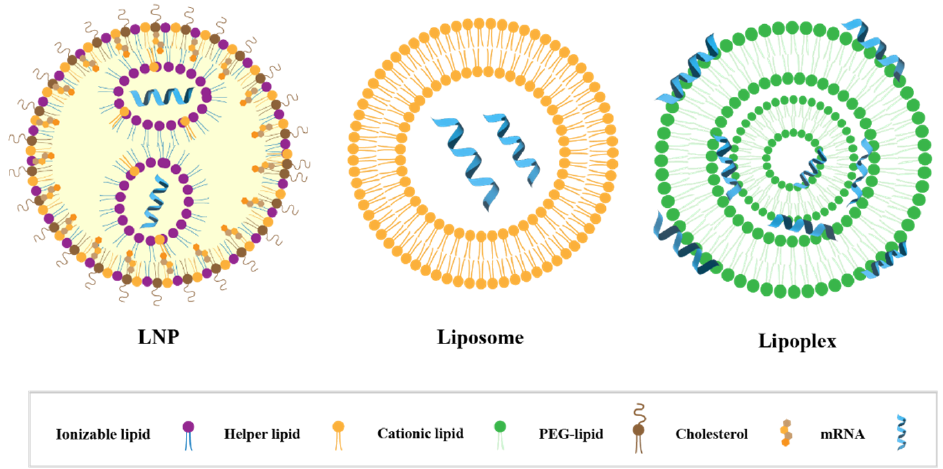
Figure 2. The schematic illustrations of the LNP, liposome, and lipoplex for mRNA delivery.